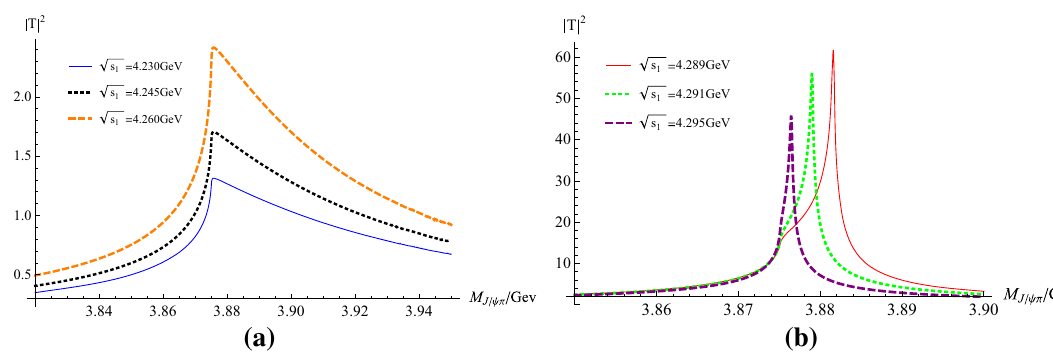
√ s 1 : a the ATS is on the second